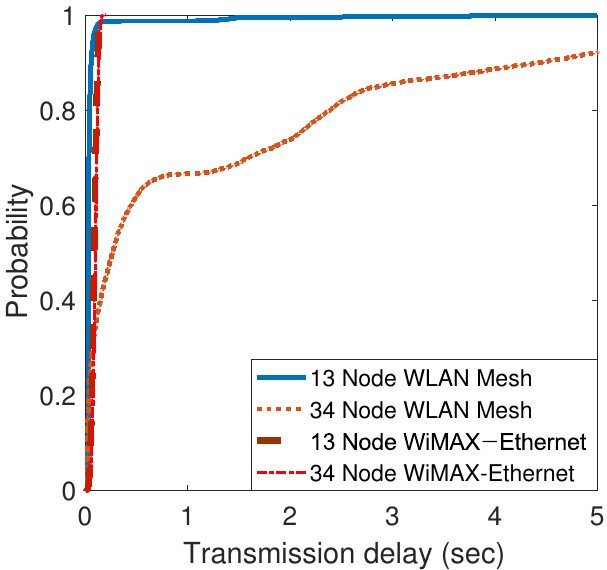
Figure 13. The CDF of the packet transmission delay.